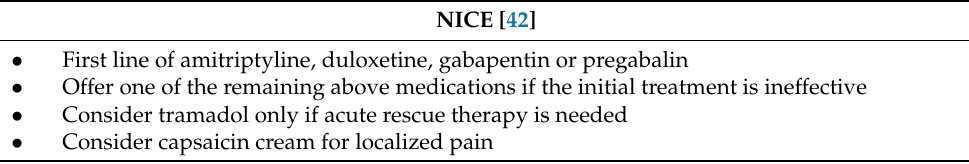
Table 2. Clinical guidelines on neuropathic pain in adults for pharmacological management in non-specialist settings from the National Institute for Health and Care Excellence